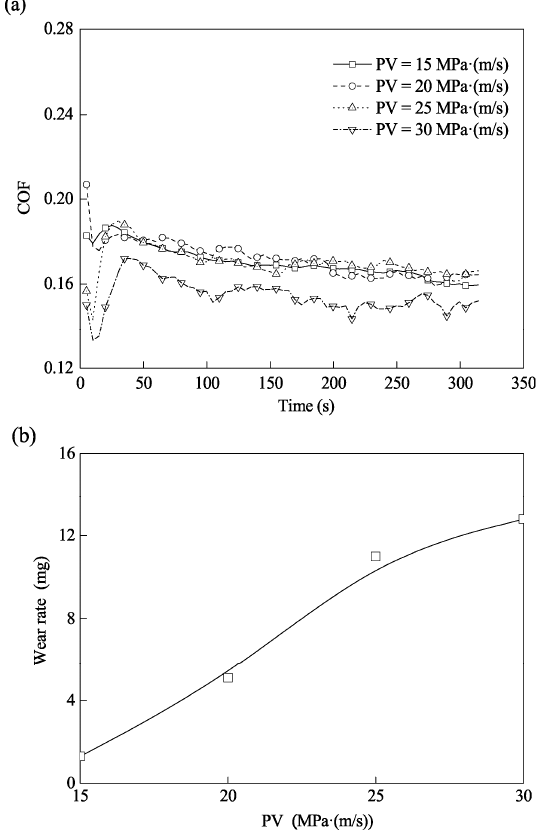
Fig. 12 (a) COFs and (b) wear rate with the S07 steel disk with DLC film under the water-lubricated conditions.